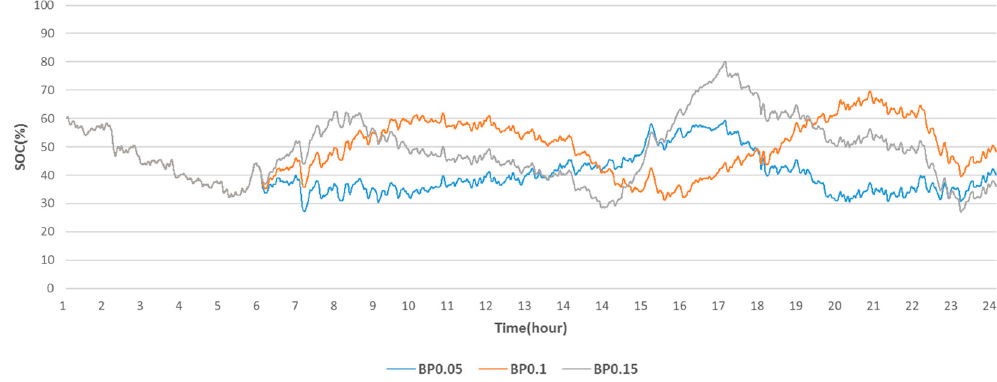
Figure 7. SOC of ESS in real-time operation simulation (Case 3—optimal scheduling algorithm with real-time SOC management).